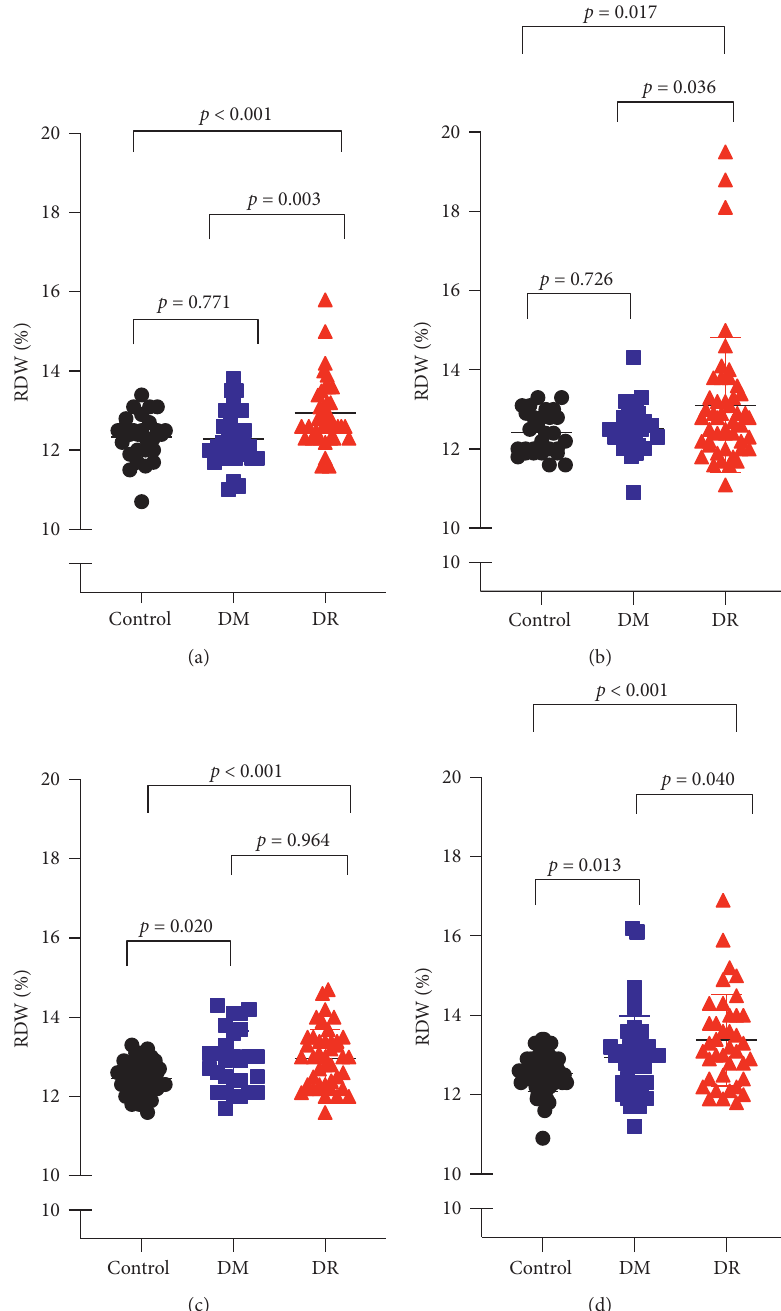
Figure 3: Distribution of RDW among subgroups by age and gender. (a) The distribution of RDW in the men aged under 58. (b) The distribution of RDW in women aged under 58. (c) The distribution of RDW in the men aged over 58. (d) The distribution of RDW in women aged over